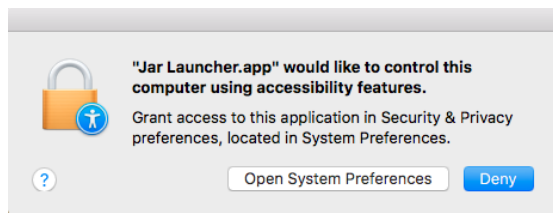
Figure 7. Message of OS X before launching